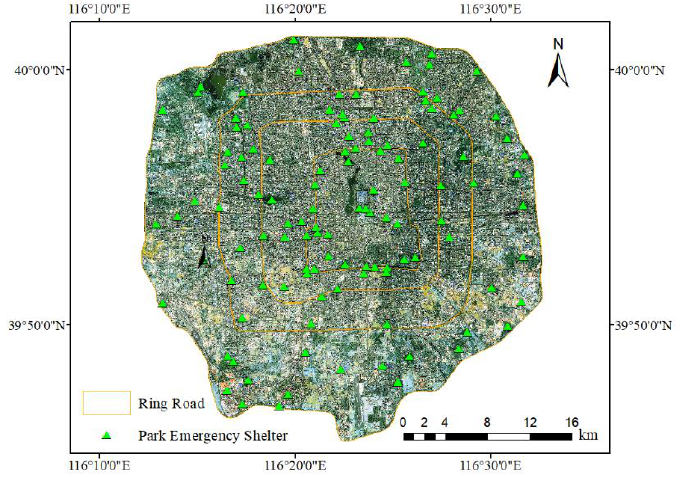
Figure 5. Spatial distribution of park emergency shelter sites within the Fifth Ring Road of Beijing.